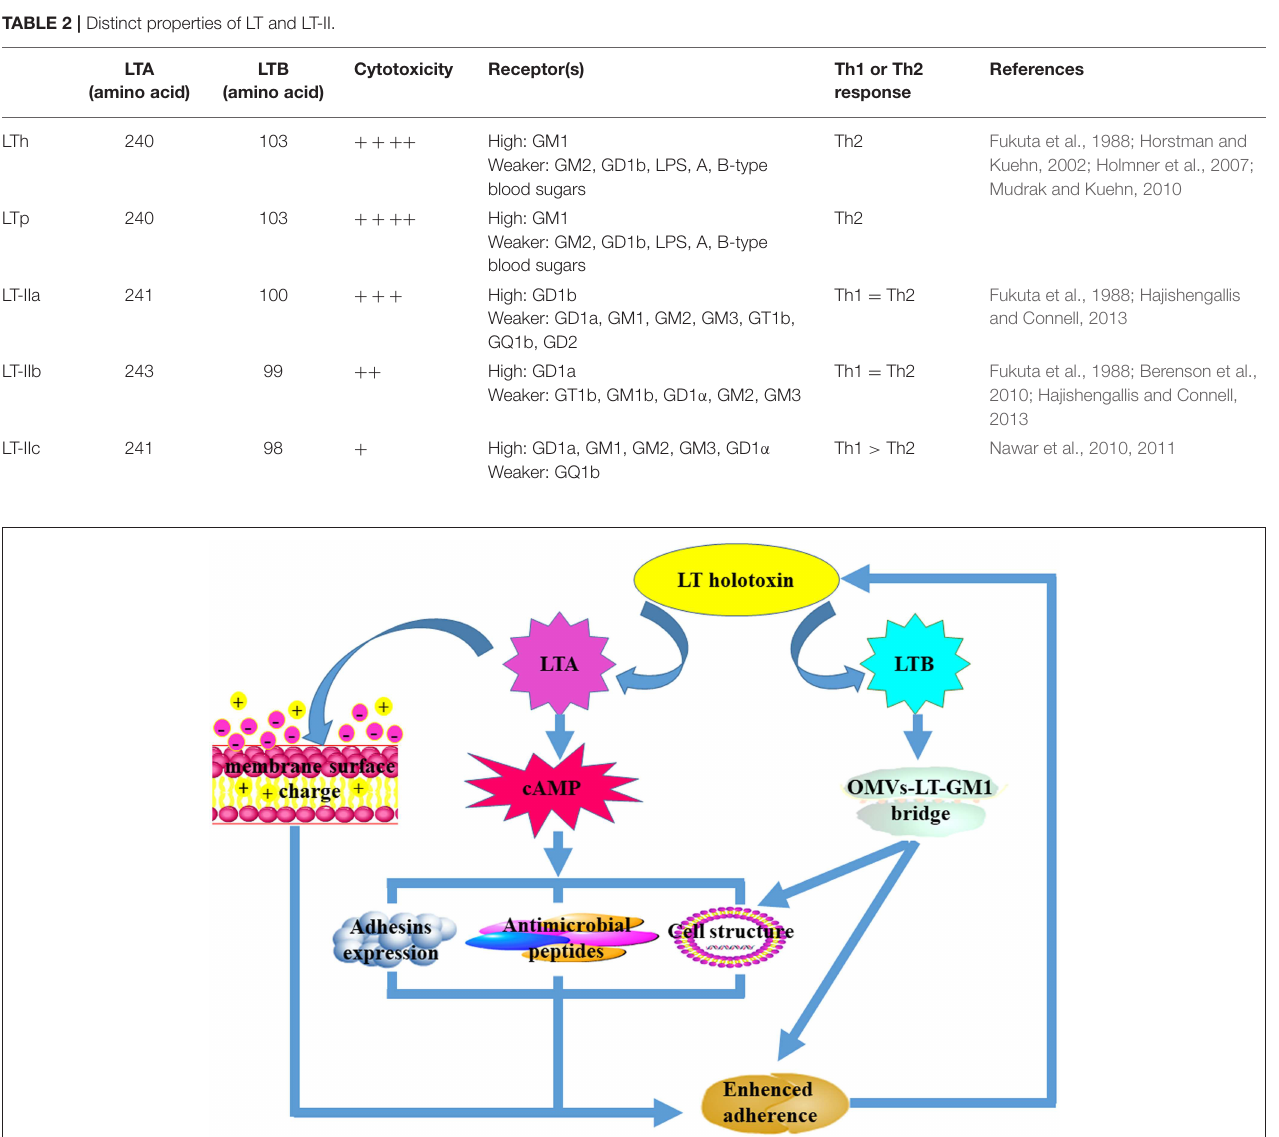
FIGURE 1 | The mechanisms that underpin LT-mediated enhancement of bacterial adherence. Both LTA and LTB subunits are required for LT-mediated enhancement of bacterial adherence. The LTA subunit improves bacterial adherence predominantly by decreasing the cell membrane surface charge and the expression of antimicrobial peptides, increasing the expression of adhesins on the surface, and altering host cell structure. The LTB subunit facilitates bacterial adherence mainly by forming the “OMVs-LT-GM1” bridge after interaction with the GM1 receptors. Alteration of the host cell membrane can also enhance bacterial